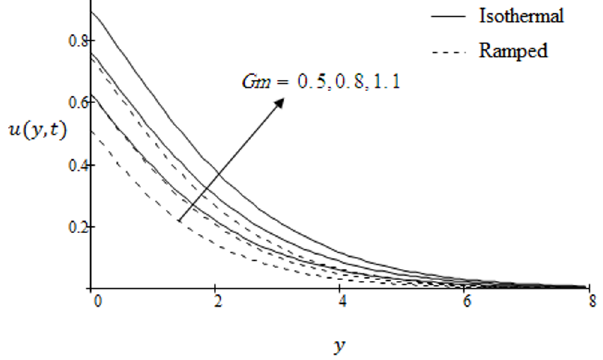
Figure 3. Velocity profiles for different values of Gm when the plate applies a constant shear stress f ~{ 0 : 25 .